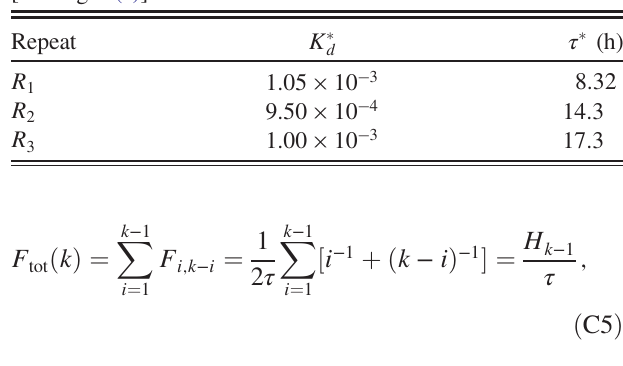
TABLE II. Best-fit parameters K (cid:4) of the experimental datasets c ¼ 1 , 3, 10 for the three repeats R 1 – 3 [see Fig. 6(a)].